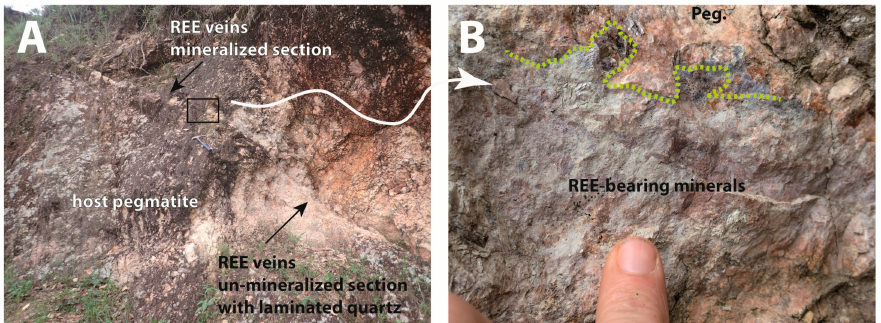
Figure 8. The Murambi occurrence. ( A ) REE-bearing veins within the pegmatites. ( B ) Corrosion gulfs along the pegmatite wall rocks.